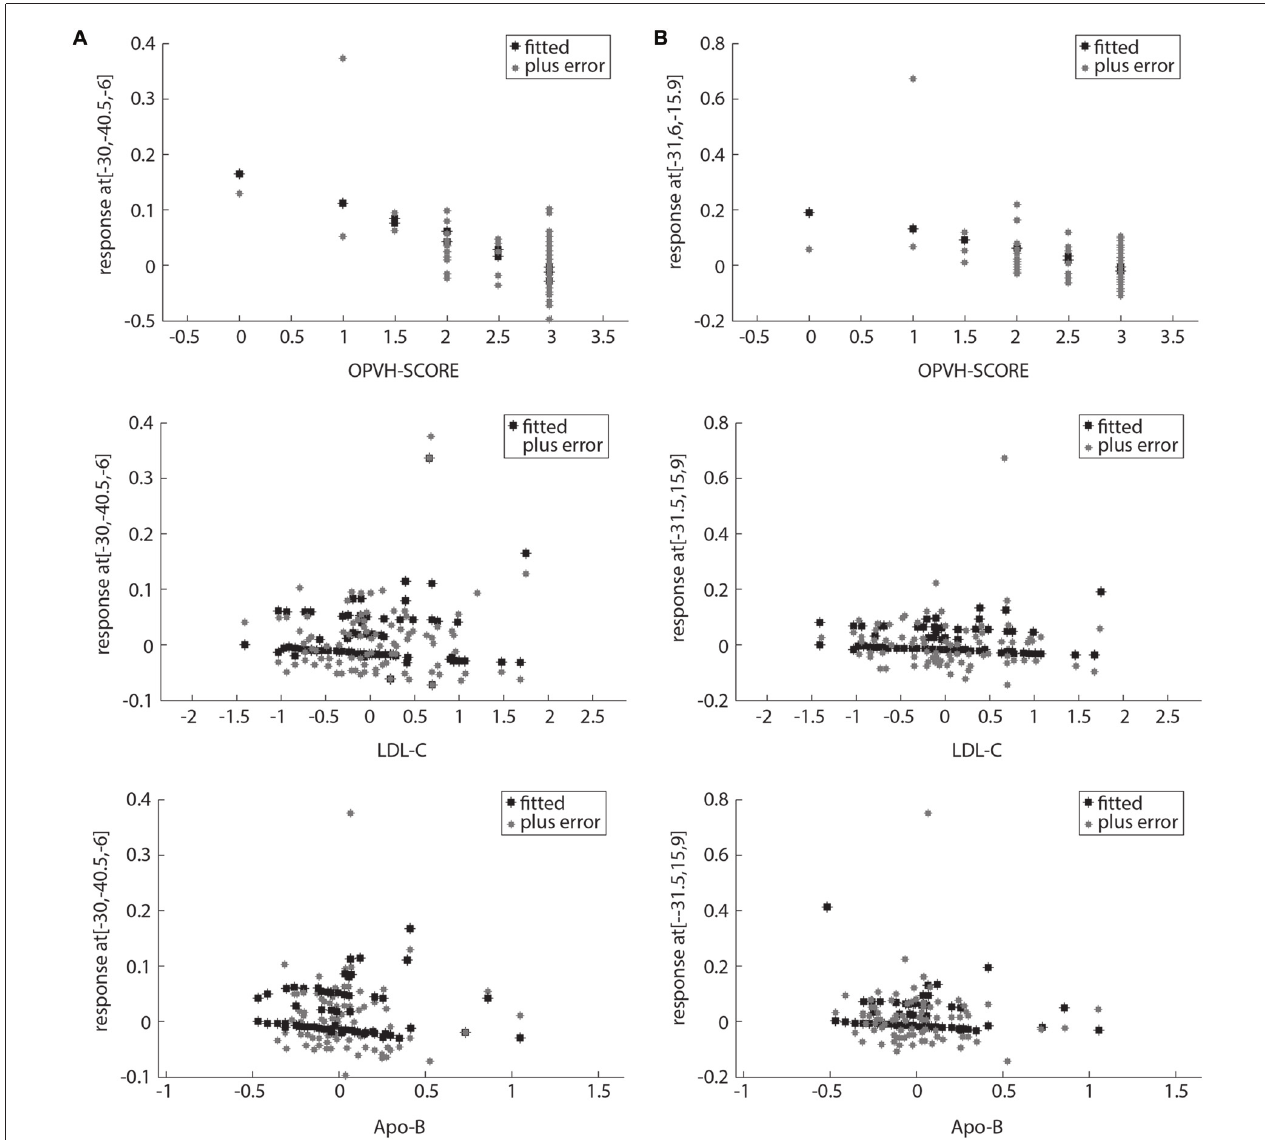
FIGURE 4 | Scatter plots of the relationship between potential clinical risk factors and the reduced GM in OPVHs patients. (A) Scatter plots of the relationship between potential clinical risk factors and reduced GM in the left precentral gyrus. (B) Scatter plots of the relationship between potential clinical risk factors and reduced GM in left insula cortex. The reduced GM volume of the left precentral gyrus and insula cortex were correlated with Fazekas score, low-density lipoprotein cholesterol (LDL-C) and apolipoprotein-B